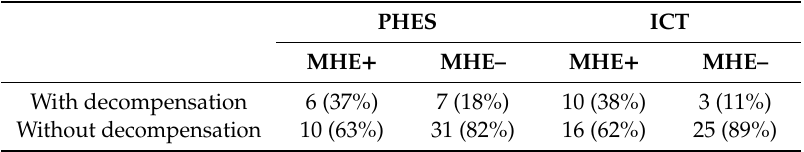
Table 2. Progression of disease depending on the previous diagnosis of MHE based on PHES and ICT. p -values obtained by Fisher exact test for PHES = 0.17 and for ICT = 0.026.